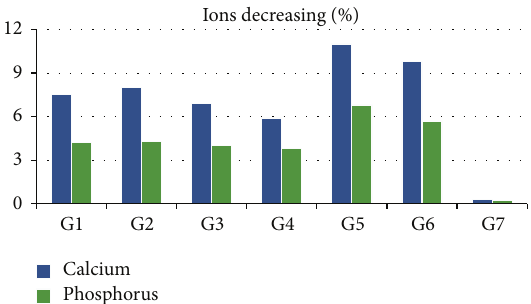
Figure 5: It shows the results for the ions decreasing of calcium and phosphorous after acid